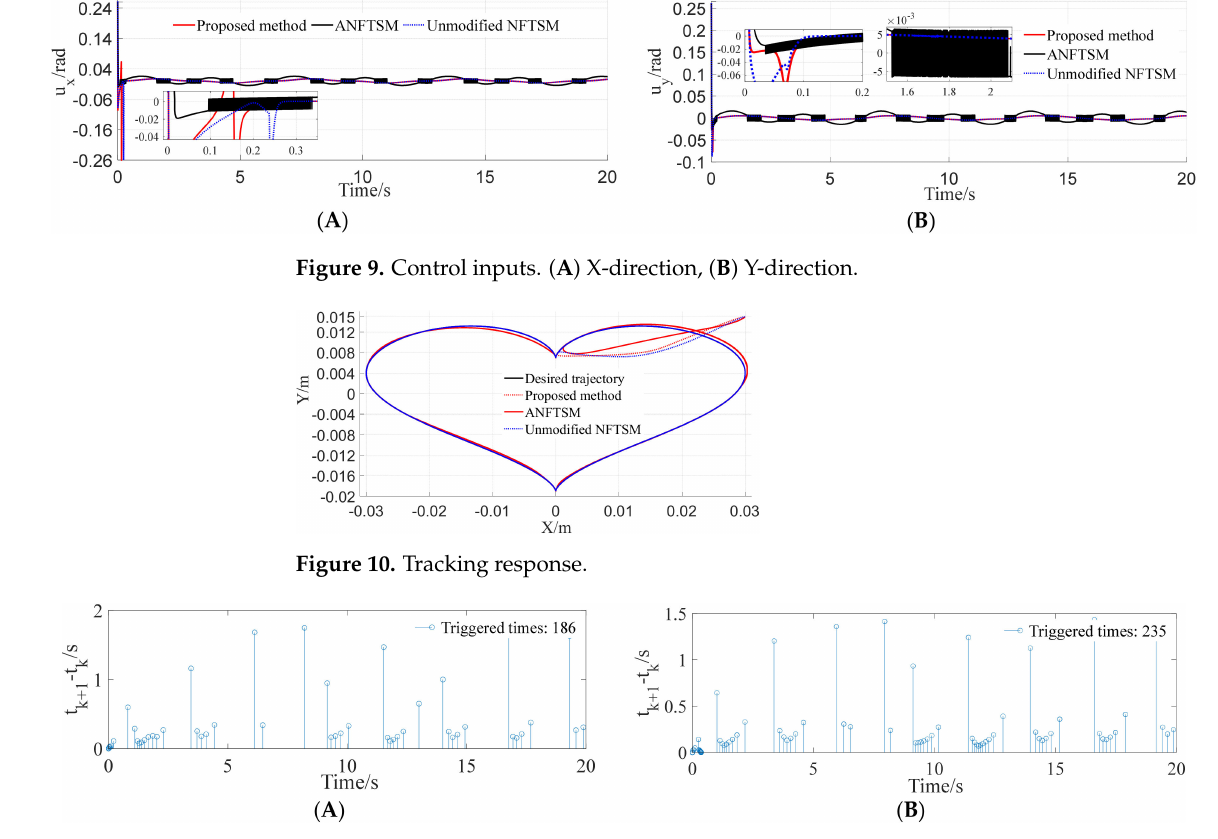
Figure 11. Triggered intervals. ( A ) X-direction, ( B )